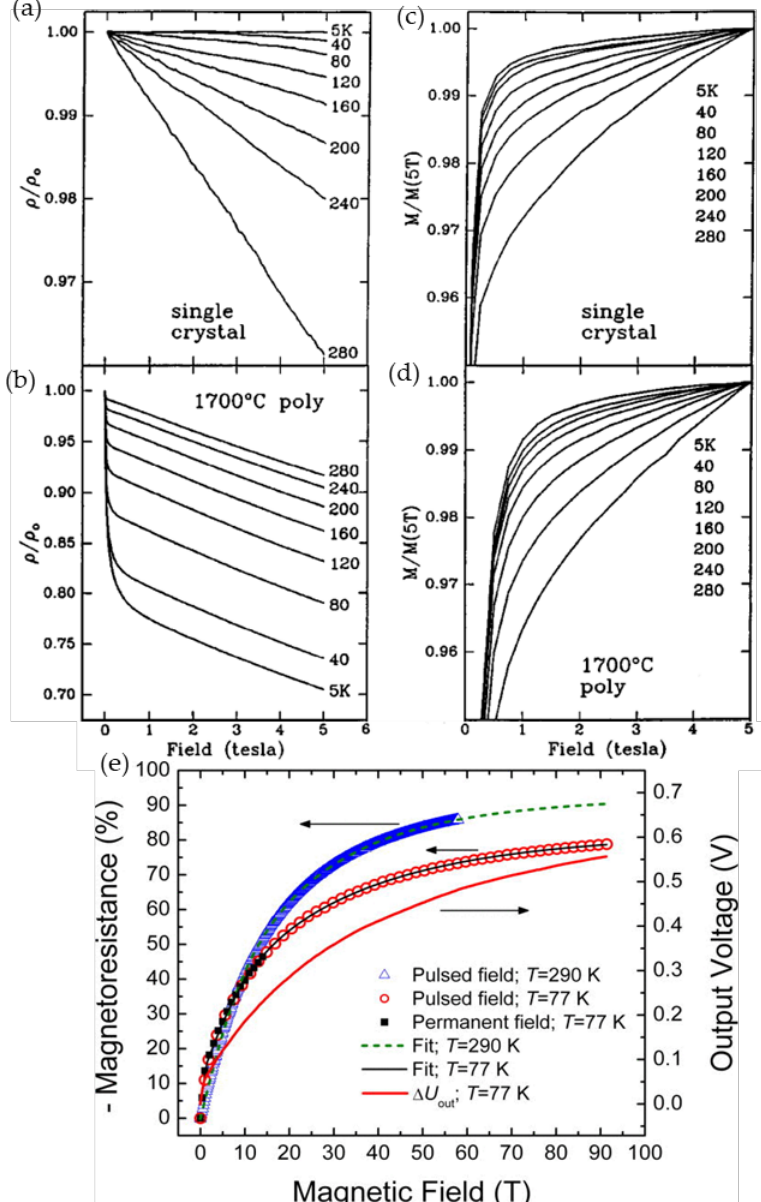
Figure 6. The magnetic field dependences of the normalized resistance ( a , b ) and magnetization (normalized to the 5 T value) ( c , d ); for La 2/3 Sr 1/3 MnO 3 ceramic samples at various temperatures from 5 to 280 K. Reprinted with permission [57], © 1996 American Physical Society; and ( e ) MR vs. B dependences of nanostructured 400 nm thickness La 0.83 Sr 0.17 MnO 3 film. Measurements performed in a static magnetic field (square symbols) and pulsed field (circular and triangular symbols corresponding to 77 K and 290 K temperatures, respectively). The solid red line (right scale) represents magnetic field dependence of output voltage (sensor’s response) when pulsed magnetic field of 91.4 T was applied. “Fit” curves show fitting results by using modified Mott’s hopping model taking into account contributions of nanocrystallites and grain boundaries. Reprinted with permission from [62], copyright 2012 IOP Publishing.